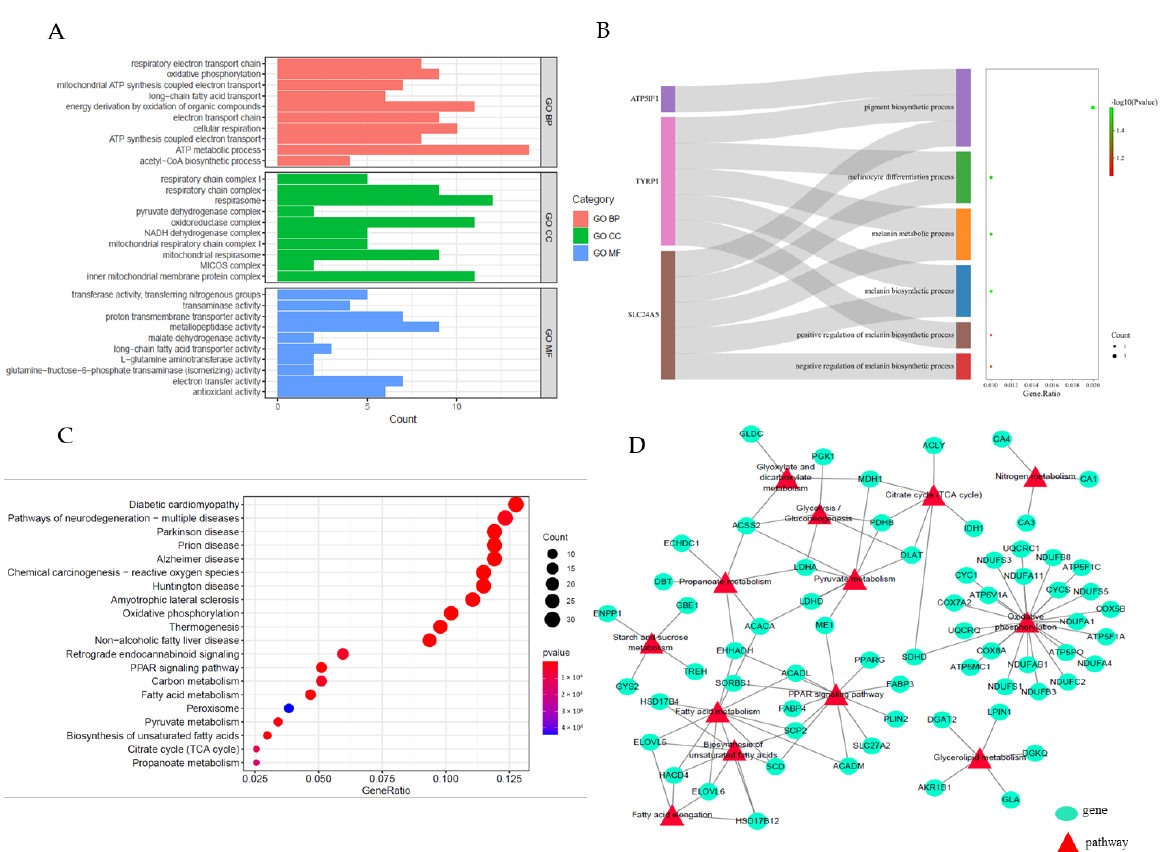
Figure 3. Functional enrichment analyses of DEGs: ( A ) GO enrichment annotation of DEGs; ( B ) Significant GO-BP terms related to pigmentation; ( C ) KEGG enrichment annotation of DEGs; ( D ) The interaction network between lipid-related mRNAs-pathway.